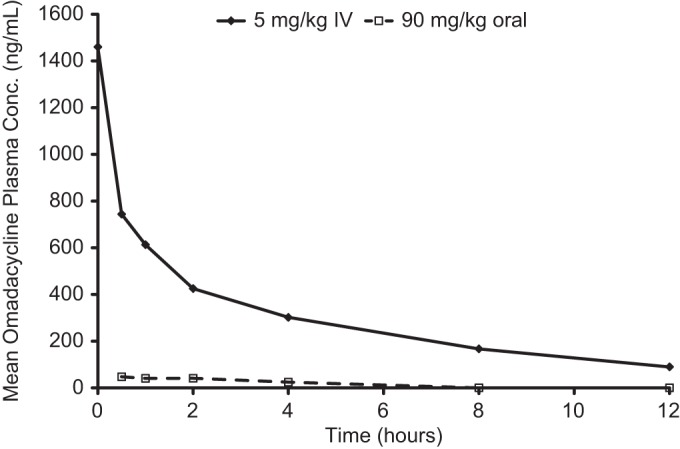
Mean concentrations of omadacycline in rat plasma following a single i.v. dose of 5 mg/kg 14C-omadacycline or an oral dose of 90 mg/kg 14C-omadacycline to HW rats (n = 3).